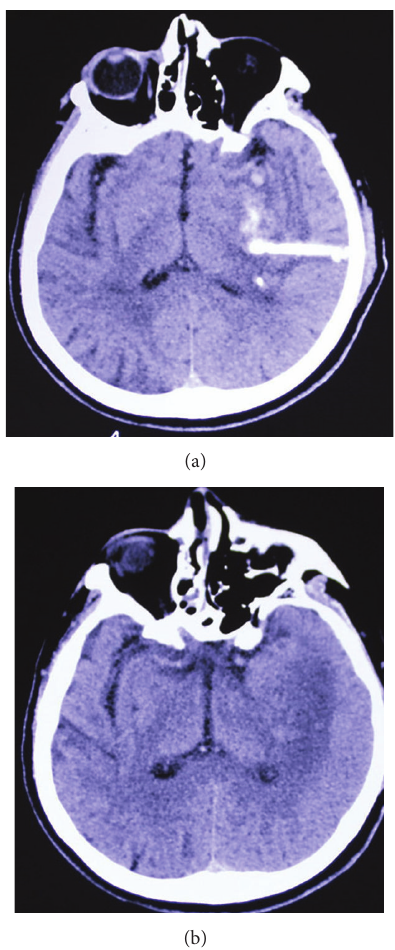
Figure 4: Cranial CT images of a patient before (a) and 6 months after BMSCs transplantation